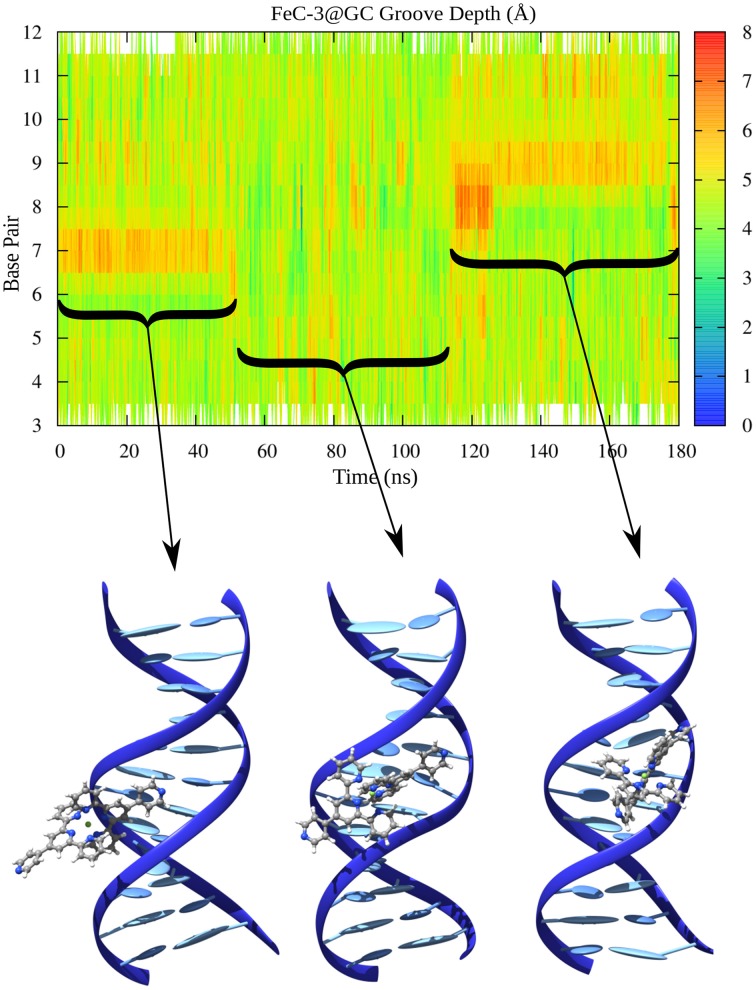
Minor Groove width for FeC-3 interacting with poly(dG)-poly(dC). Representative conformations of the equilibrium modes are also represented in cartoon.